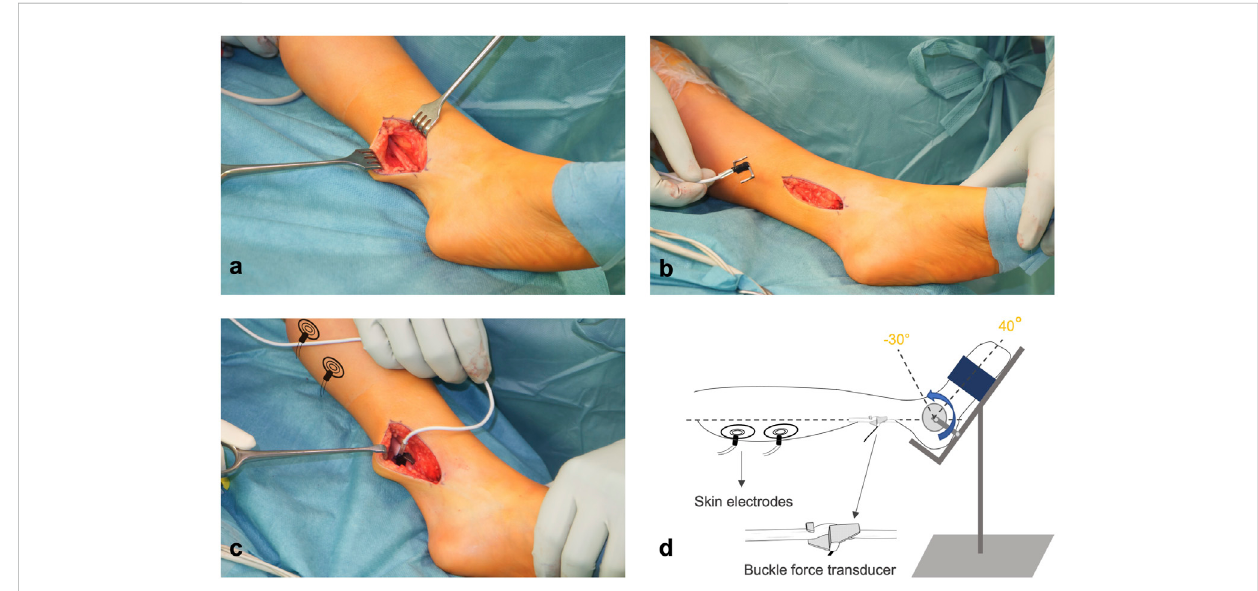
FIGURE 1 Intraoperative experimental setup. (A) Achilles Tendon is exposed under general anesthesia and (B,C) the s-shaped buckle force transducer is attached. (D) Two electrodes are placed on the skin over the triceps surae muscle for active force measurement. The foot is mounted on an apparatus with a heavy ground plate and an ankle angle adjuster. The foot is fi xed in the apparatus to collect isometric force